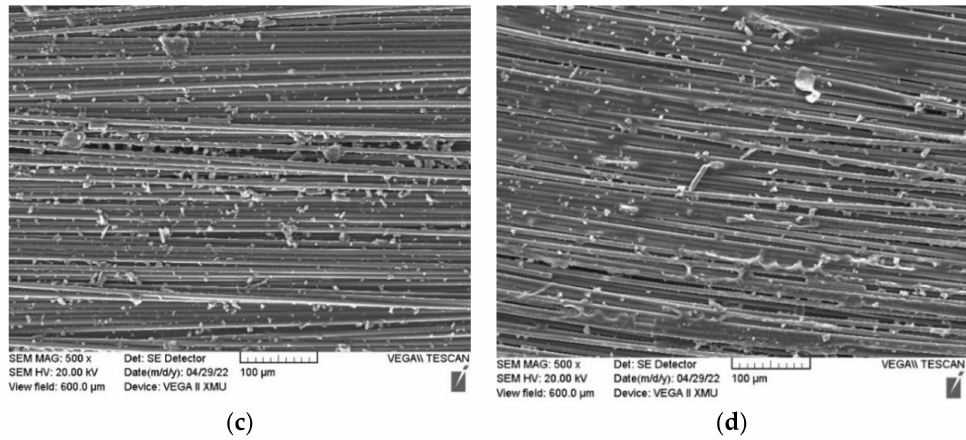
Figure 8. Morphology of microinfiltration of GO-CF/EP composites. ( a ) [XXXXXX] 6 ; ( b ) [XYXXXX] 6 ; ( c ) [XYYXXX] 6 ; ( d ) [XYXYXY] 6